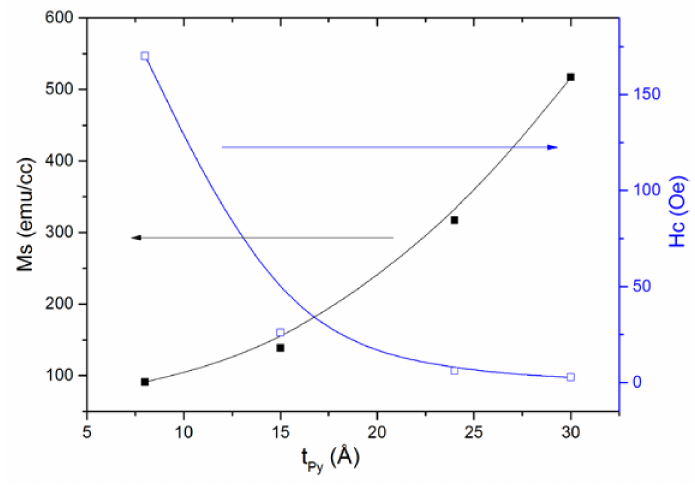
Figure 5. Evolution of the saturation magnetization M S —full squares—and coercive field H c —empty squares—(obtained at 5 K) versus Py thickness t Py . The lines are guides to the